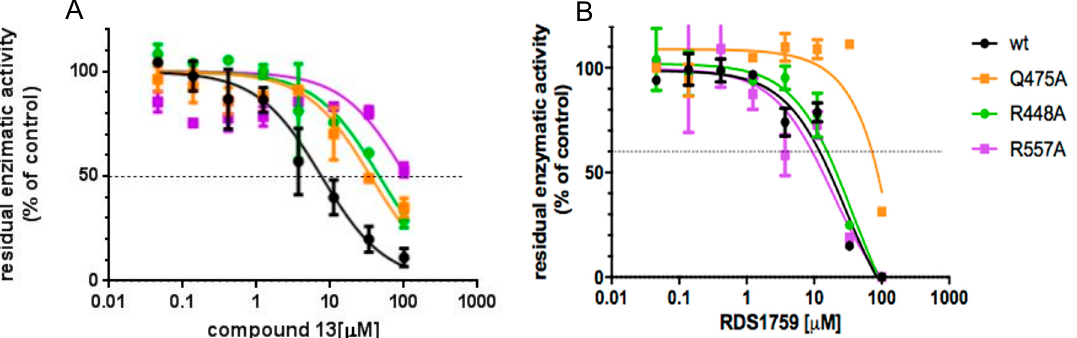
Figure 4. Inhibitory profile of compound 13 against the HIV-1 RT RNase H function. ( A ) Compound 13 inhibition of HIV-1 RT RNase H activities; ( B ) RDS1759 inhibition of HIV-1 RT RNase H activities. Data represent the mean and SD of two experiments.